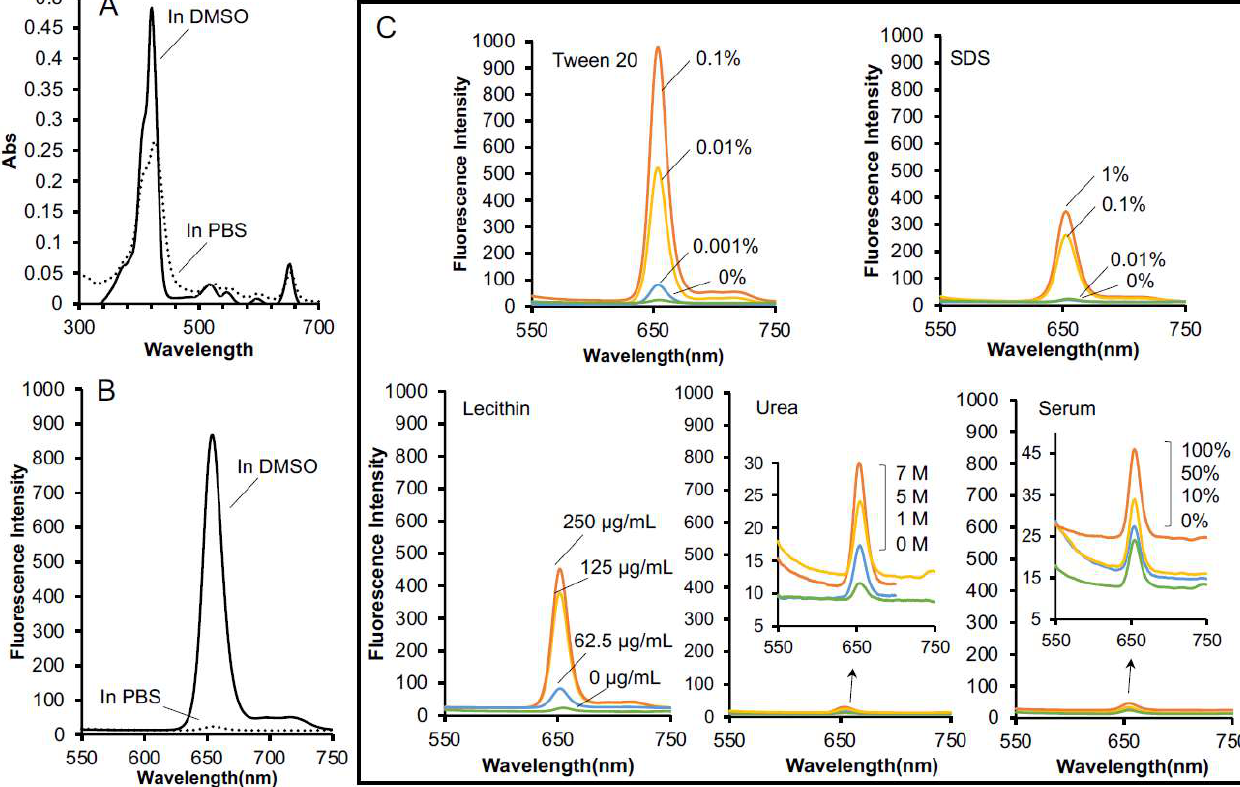
Figure 2. Characterization of the micelle formation of SMA@mTHPC. The UV–VIS spectra ( A ) and fluorescence spectra ( B ) of SMA@mTHPC in PBS as well as in DMSO were measured. The fluorescence spectra of SMA@mTHPC in the presence of detergent (Tween 20, SDS), the cell membrane component (lecithin), urea, and serum are shown in ( C ). See text for